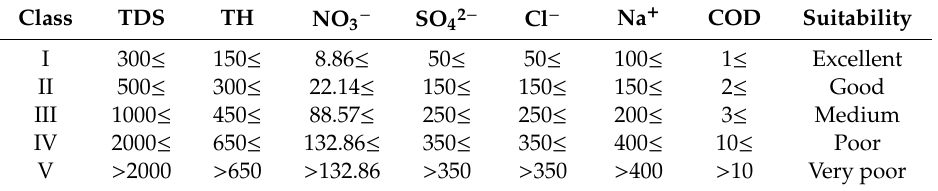
Table 4. Water quality standards of groundwater (Unit: mg / L; COD: chemical oxygen